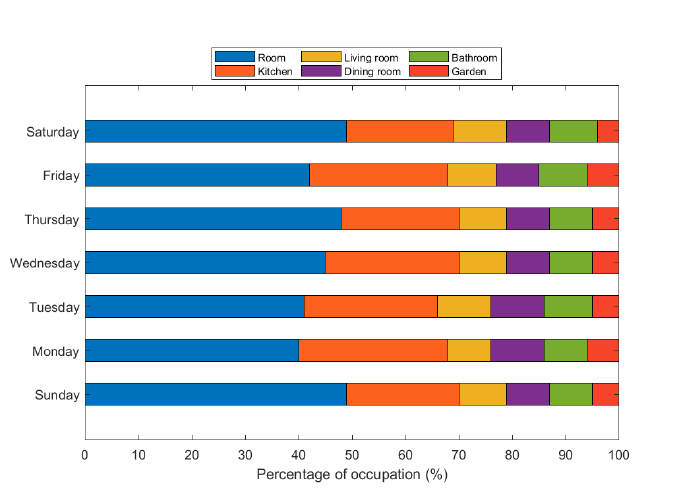
Figure 6. Average occupancy percentage per person in main areas of living place.